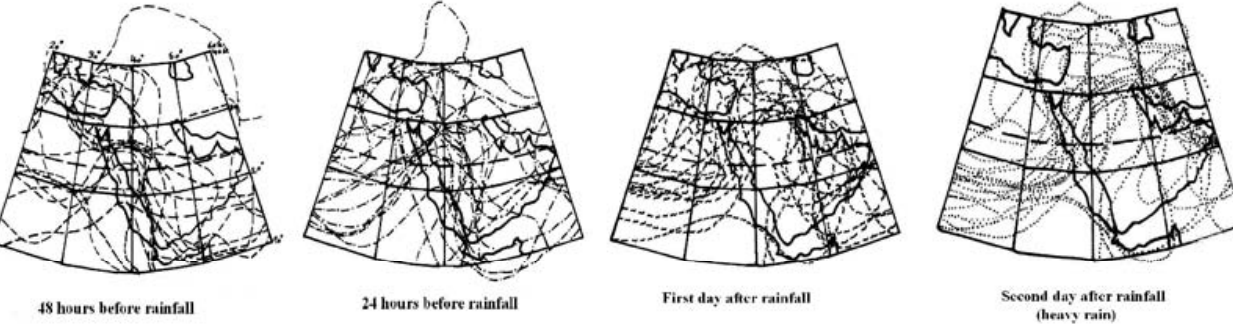
Fig. 21. The mean positions of 1015hPa isobars of the 20 selected floods, two days before starting the rainfall (left pictures) and in first day